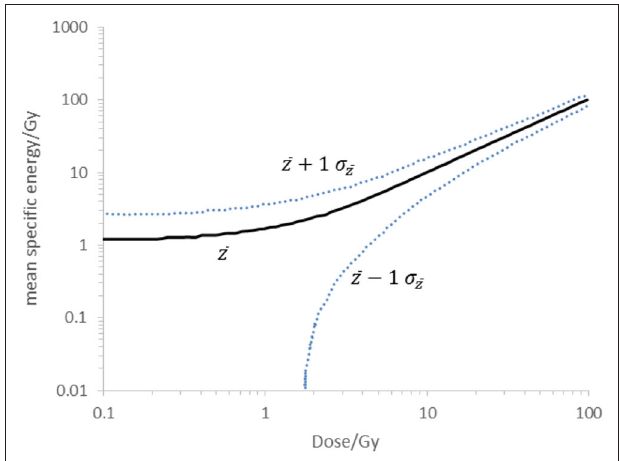
FIGURE 1 | Multi-event mean specific energy in a critical cylindrical volume of 1 µ m in diameter (volume without 0 events) at a given dose, D . Calculation for a 60 MeV modulated proton beam at the Bragg peak with y F = 7 keV · µ m − 1 and y D = 7 keV · µ m − 1 (solid line). The dotted lines indicate the borders of the specific energy within 1 SD of the mean value in the actual energy distribution. Calculation was performed following the method described by Booz [ 5].